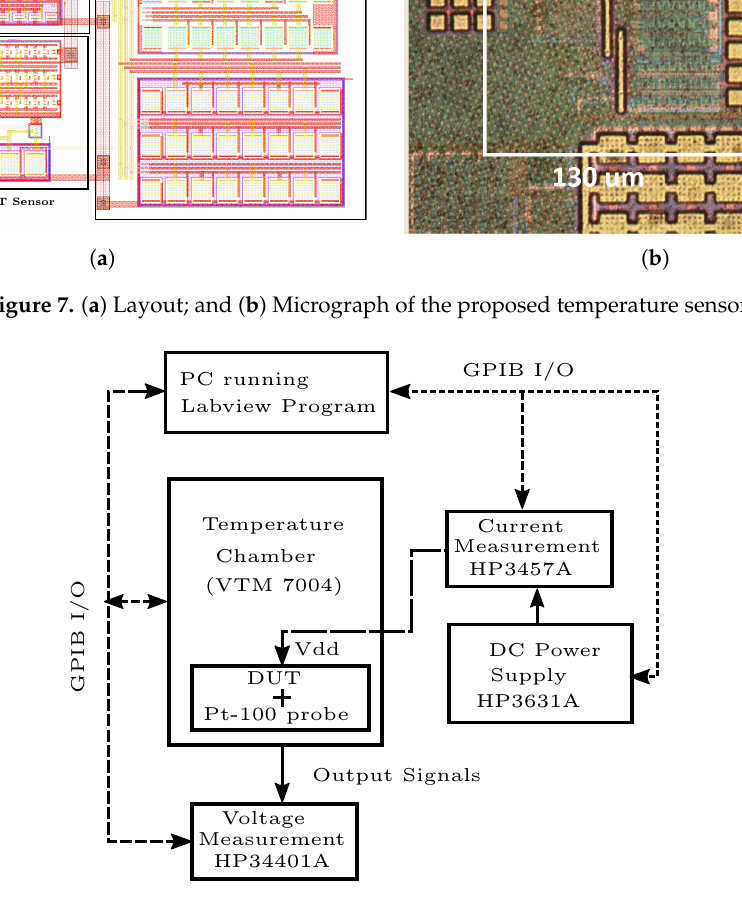
Figure 8. Block diagram of measurement